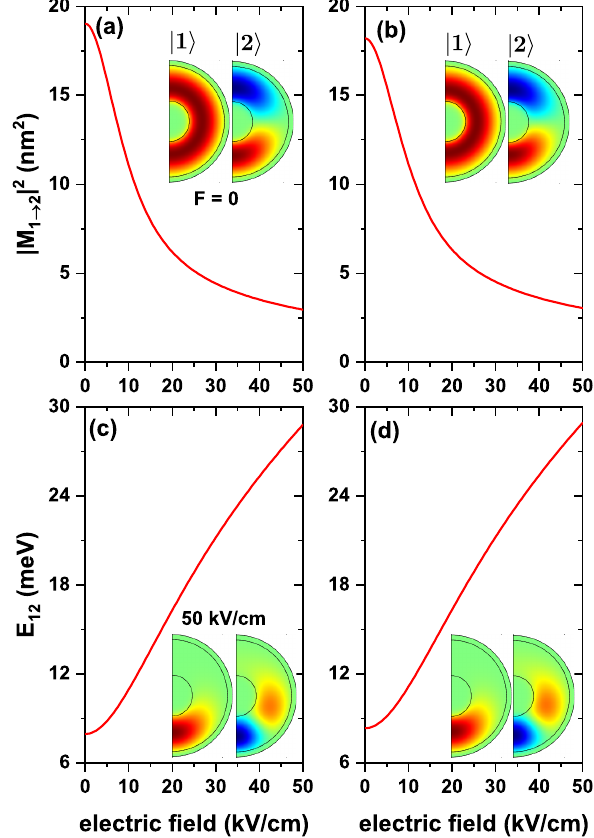
Figure 7. The variation of the | M 12 | 2 ( a , b ), and the transition energy ( c , d ), as a function of the electric field F z , for transitions from the ground state ( | 1 (cid:105) ) to the first excited state ( | 2 (cid:105) ) with m = 0, for an electron confined in a ZnS/CdS/ZnS spherical QD. ( a , c ) results without, and ( b , d ) with the effects of a donor impurity, located at the QD center, with R 1 = 4 nm, R 2 = 11 nm and R 3 = 12 nm, without external magnetic field